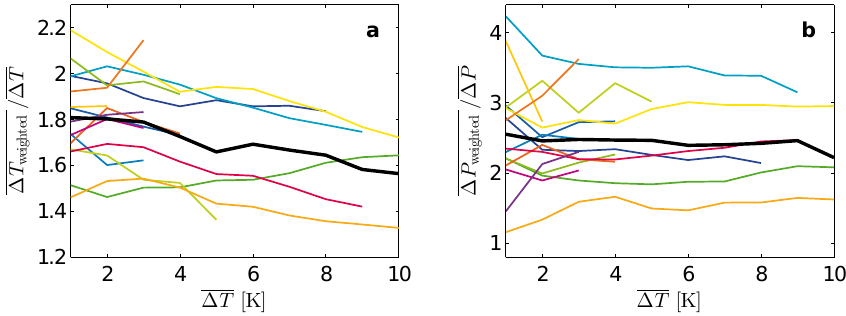
Fig. 5. Temperature and precipitation amplification at the locations of glaciers. (a) Annual mean amplification of temperature anomalies at the locations of glaciers as a function of global mean temperature anomaly 1T . (b) Annual mean amplification of relative precipitation anomalies at the locations of glaciers as a function of global mean temperature anomaly 1T . Colors as in Fig.